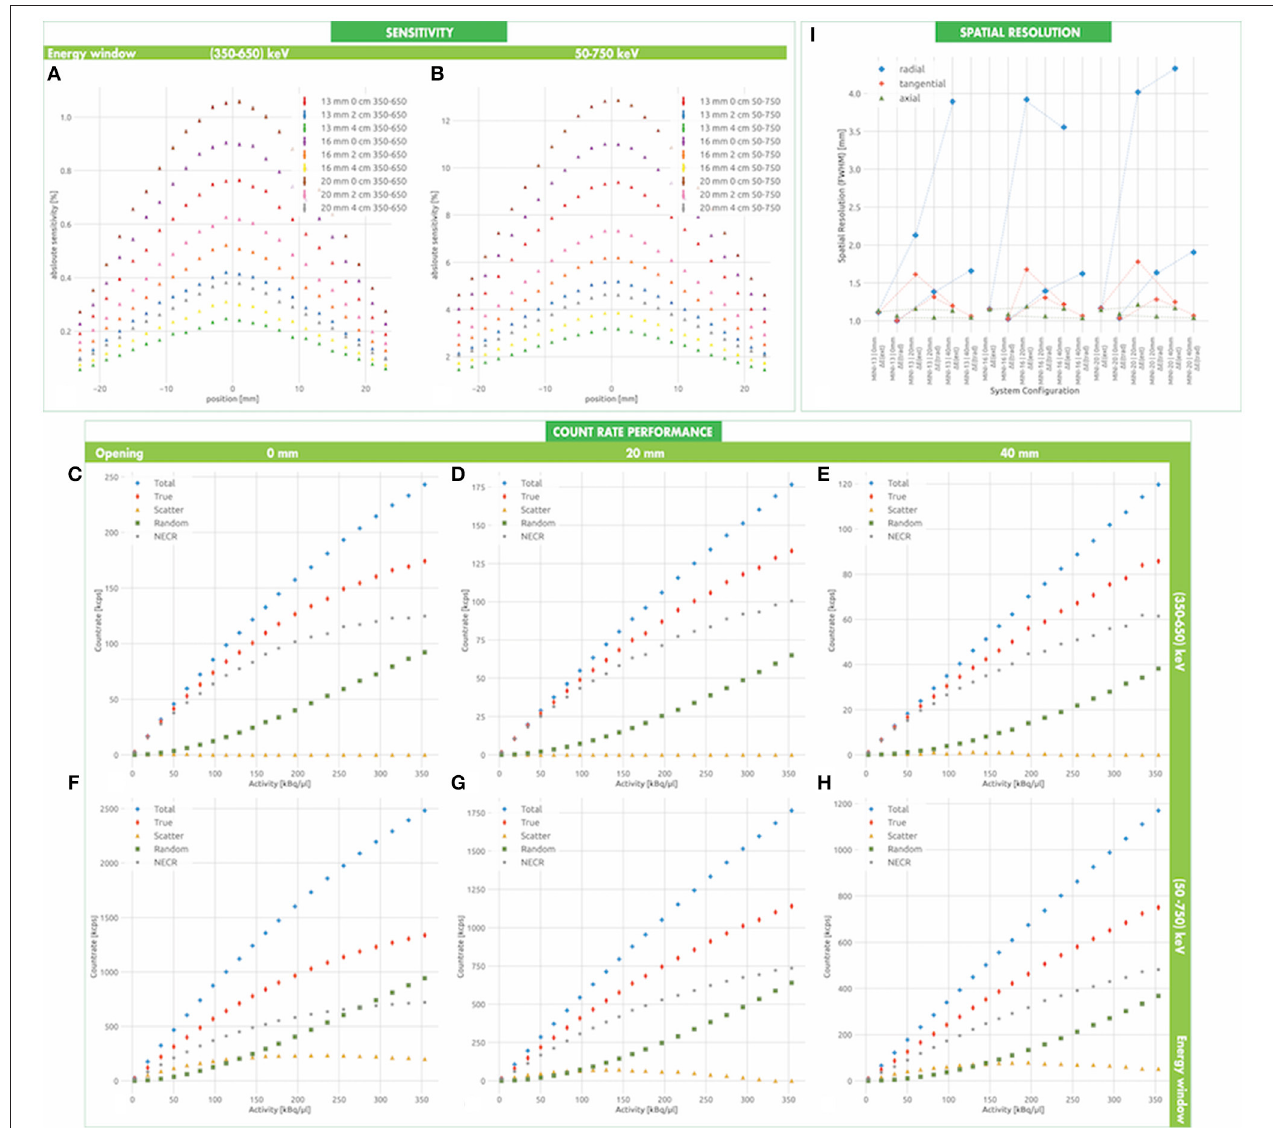
FIGURE 5 | Miniaturized system expected performances. The sensitivity is estimated for the conventional (A) and the enlarged (B) energy window at three openings of the two half-cylinders. Similarly, the count rate figure is estimated at three openings of the two half-cylinders for the conventional (C–E) and enlarged (F–H) energy window, respectively (see also Supplementary Tables 8, 9 ). The radial, tangential and longitudinal spatial resolution at the center of the FOV are reported in (I) for different energy windows and opening angles (see also Supplementary Tables 10–13 ). The dashed lines represent the spatial resolution profiles related to the same energetic window over different